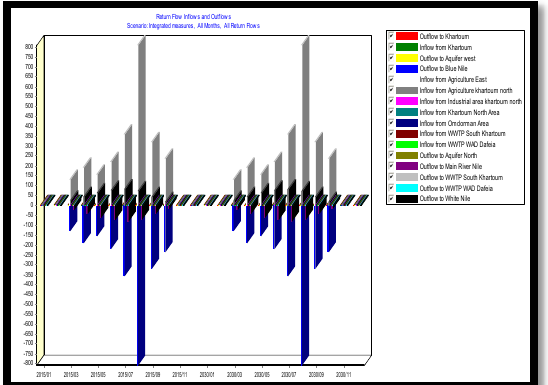
Fig (6) Return flows and outflows, scenario integrated